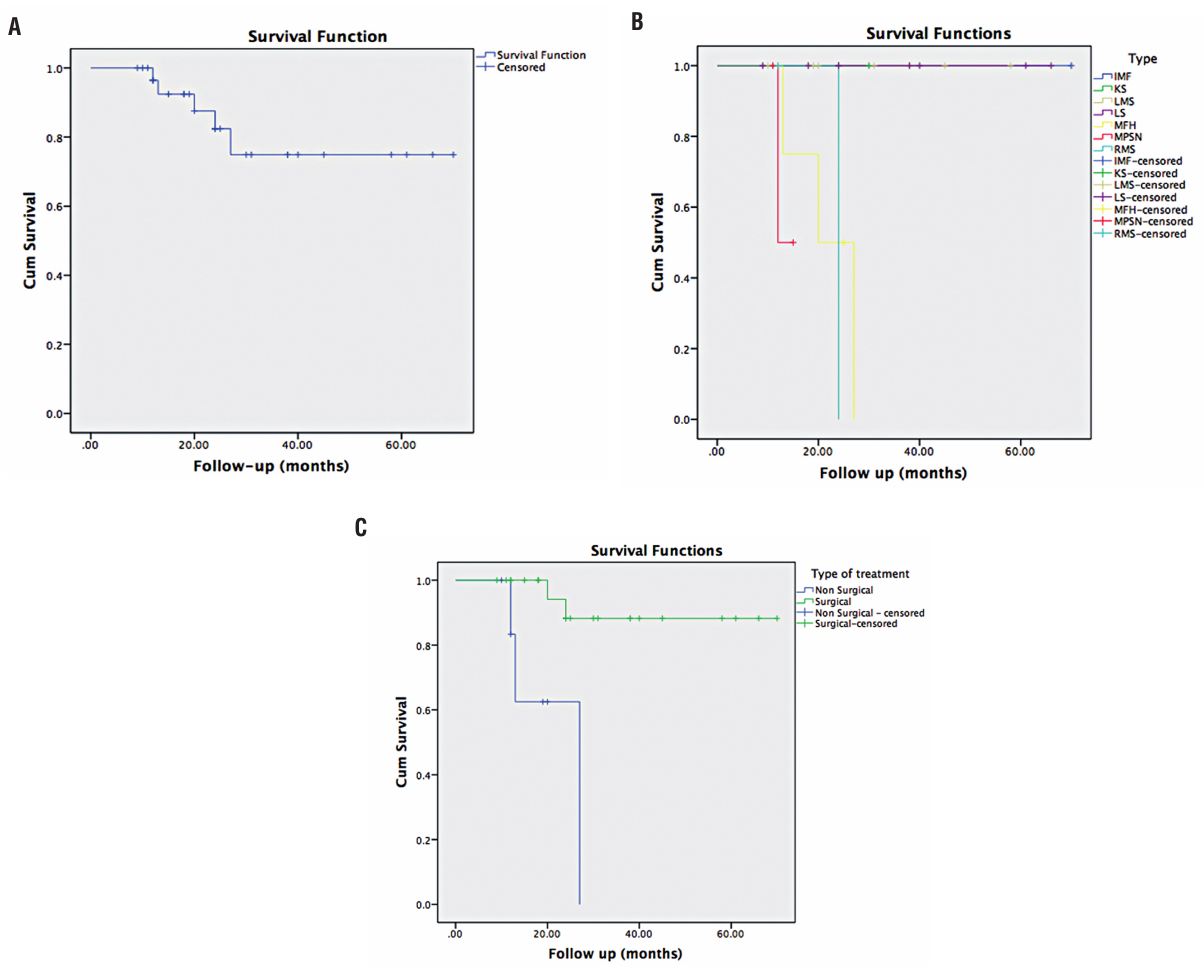
Figure 1 - Kaplan-Meier analysis of overall survival in overall cases (A), according to histological subtype (B) according to presence vs. absence of surgical resection